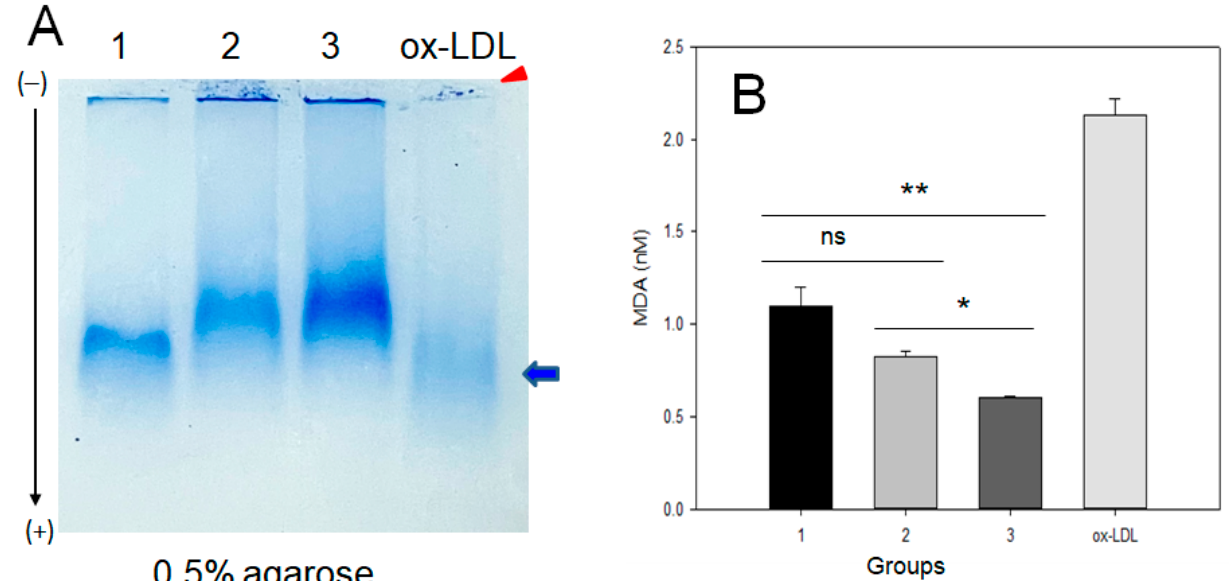
Figure 2. Native electrophoresis of LDL on agarose from each group and quantification of oxidized species. ( A ) Comparison of electromobility and aggregation extent of LDL (10 μ g) band on 0.5% agarose gel without denaturation. Lane 1, group 1 (n = 20); lane 2, group 2 (n = 16); lane 3, group 3 (n = 21); lane 4, oxLDL, Cu 2+ -treated for 4 h. Red arrowhead indicates an aggregated band of oxLDL at the loading position. The blue arrow indicates the oxLDL band position and smeared intensity. ( B ) Quantification of oxidized species using malondialdehyde standard by the thiobarbituric acid- reactive substances (TBARS) assay. MDA, malondialdehyde; oxLDL, oxidized LDL. *, p < 0.05 between group 2 and 3; **, p < 0.01 between group 1 and